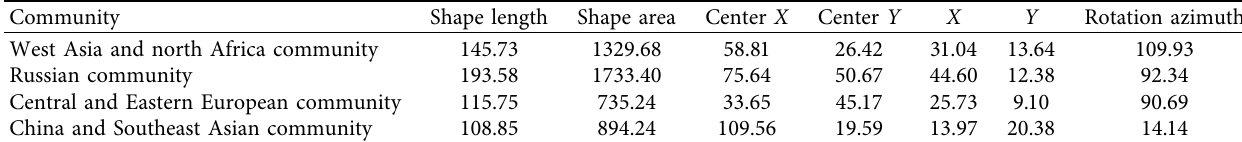
Figure 4: Te 4 community of the “belt and road” aviation network: (a) West Asia and North Africa community network, (b) Russian community network, (c) Central and Eastern European community network, and (d) China and Southeast Asian community network. Table 2: Ellipse standard deviation parameters of the